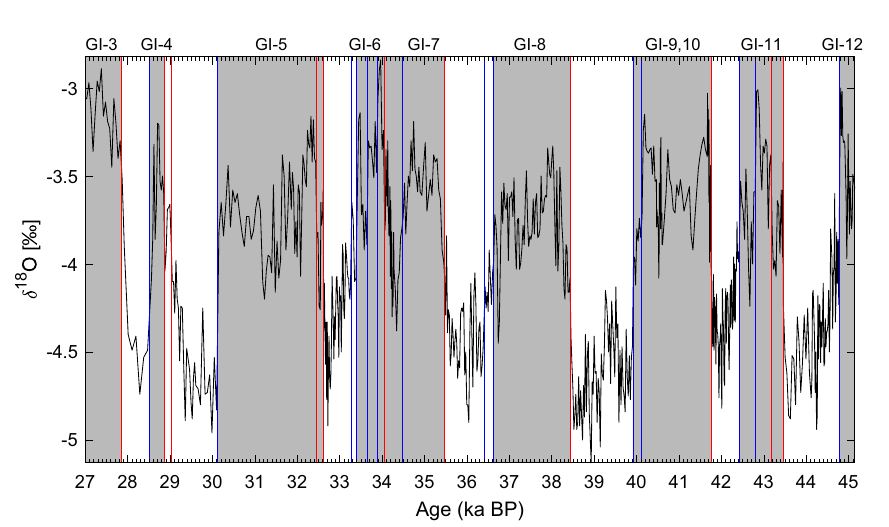
18 Figure 5. Paraiso Cave (PAR07) δ O 165 . Vertical lines represent transitions detected by the KS algorithm 19 , with colors indicating the direction of the jumps. Grey bars represent dry interglacial